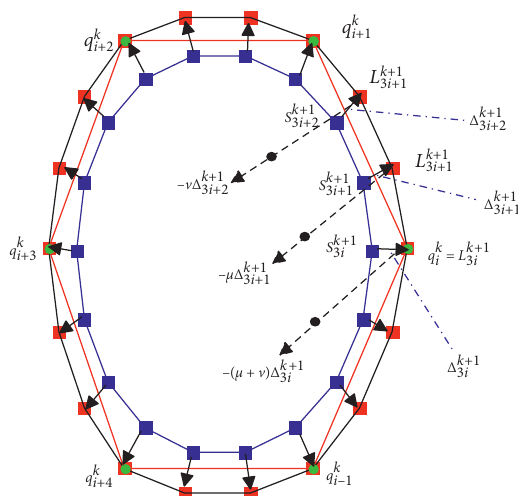
Figure 2: Graphical sketch of the construction of the refinement points of scheme